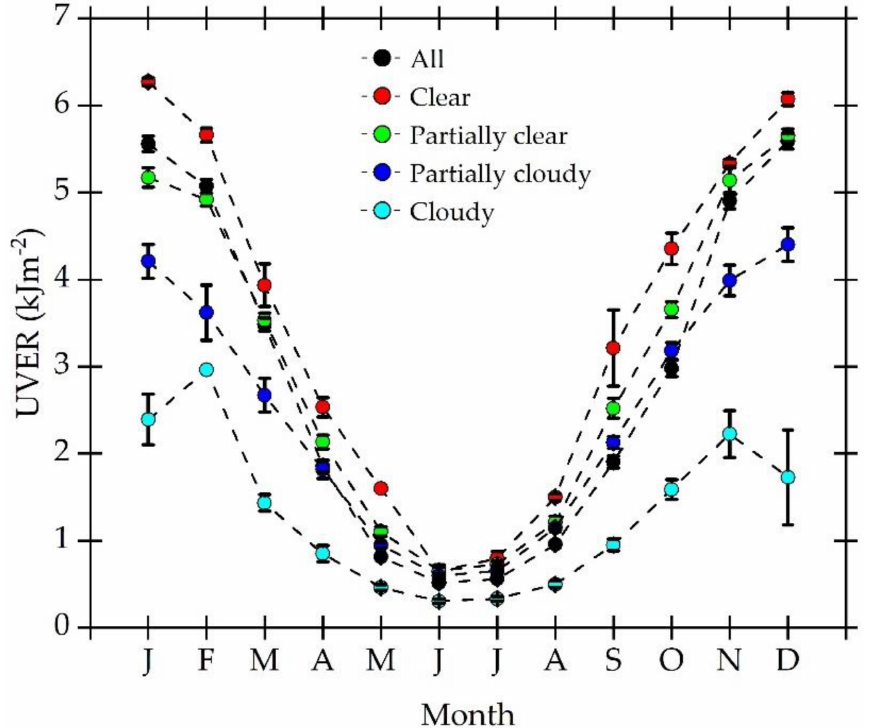
Figure 2. Seasonal distribution of monthly average daily values of UVER for all-sky, clear, partially clear, partially cloudy, and cloudy conditions observed during 2015–2019 in